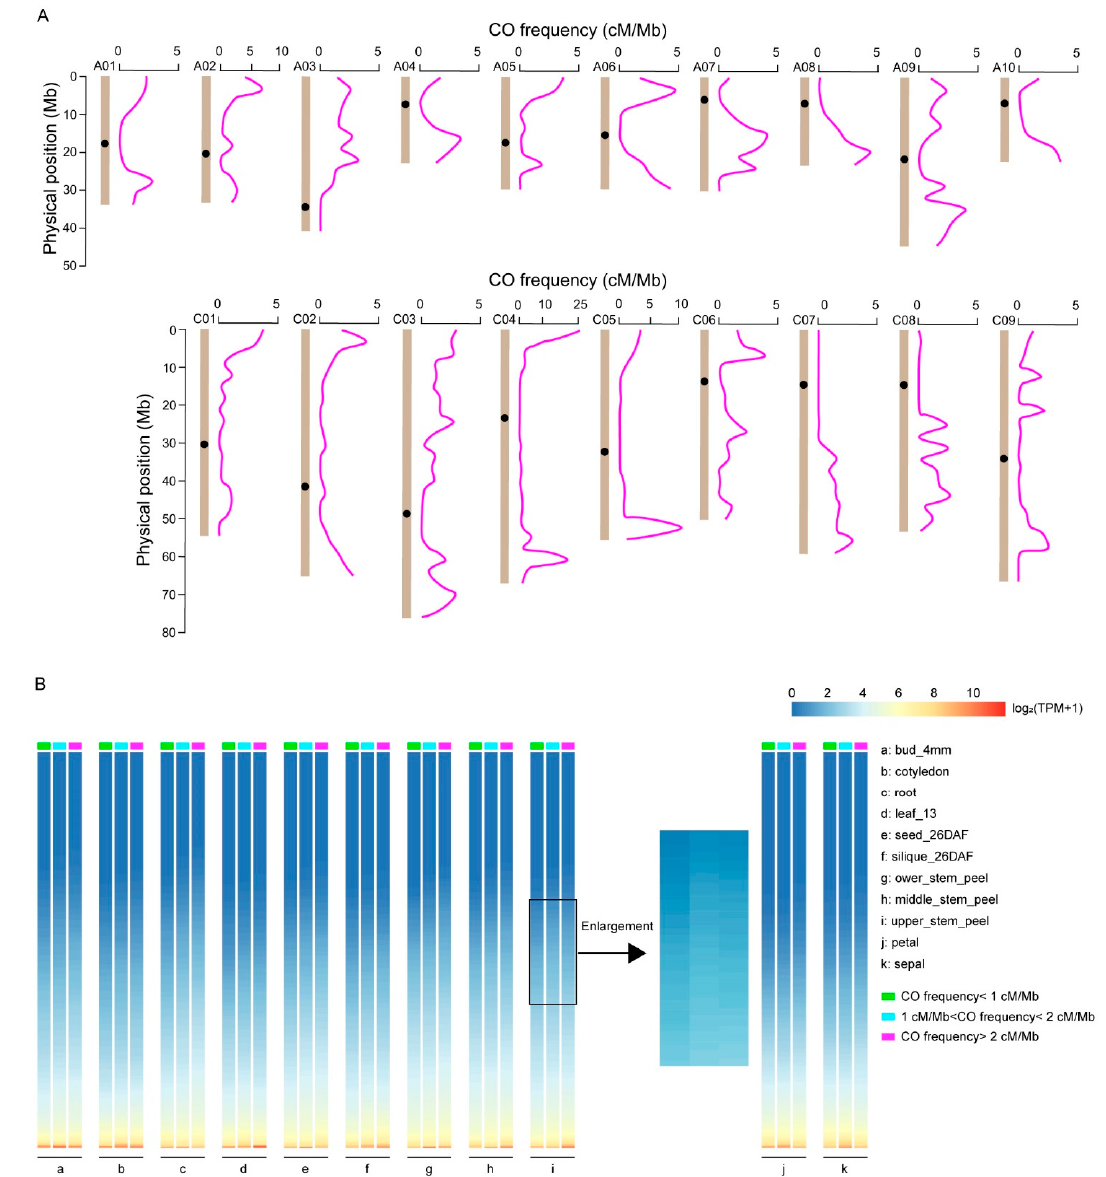
Figure 2. CO distribution pattern and gene expression levels in three intervals with different CO frequencies in B. napus . ( A ) CO frequency distribution on the 19 chromosomes of the DH population, using the ZS11 reference genome. CO frequency (cM/Mb) was calculated by genetic distance/physical length within a 3-Mb sliding window. The black dots on each chromosome represent the centromere positions. ( B ) Gene expression levels in three intervals with different CO frequencies. The genome region was divided into three intervals according to the different CO frequencies: a frequency less than 1 cM/Mb, 1 cM/Mb to 2 cM/Mb, and greater than 2 cM/Mb. A total of 11 tissues and 1000 genes randomly selected from each interval were used to analyze the gene expression level. The average gene expression level in the intervals with CO frequency > 2 cM/Mb is significantly higher than that in the intervals with CO frequency < 1 cM/Mb in the nine tissues from a to i. The enlarged diagram was used as an example to interpret the results clearly. In the rest of the two tissues (j–k), there are no significant differences in the average gene expression level among the three